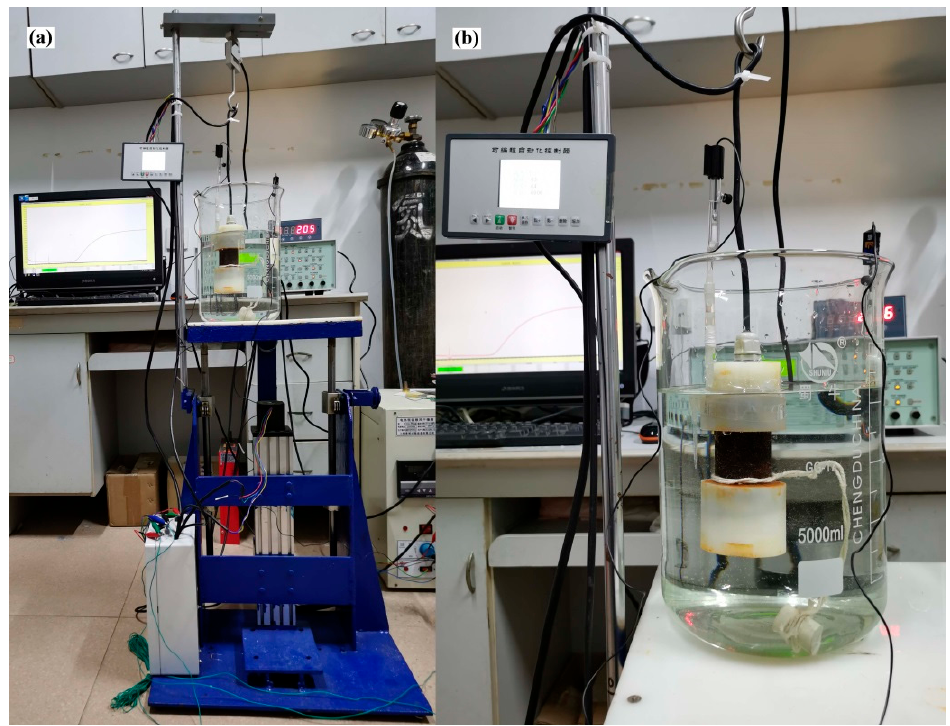
Figure 4. Photos of the hydrogen permeation test set-up under simulated tidal cycling condition in laboratory ( a ), enlarged view of electrolytic cell ( b ).